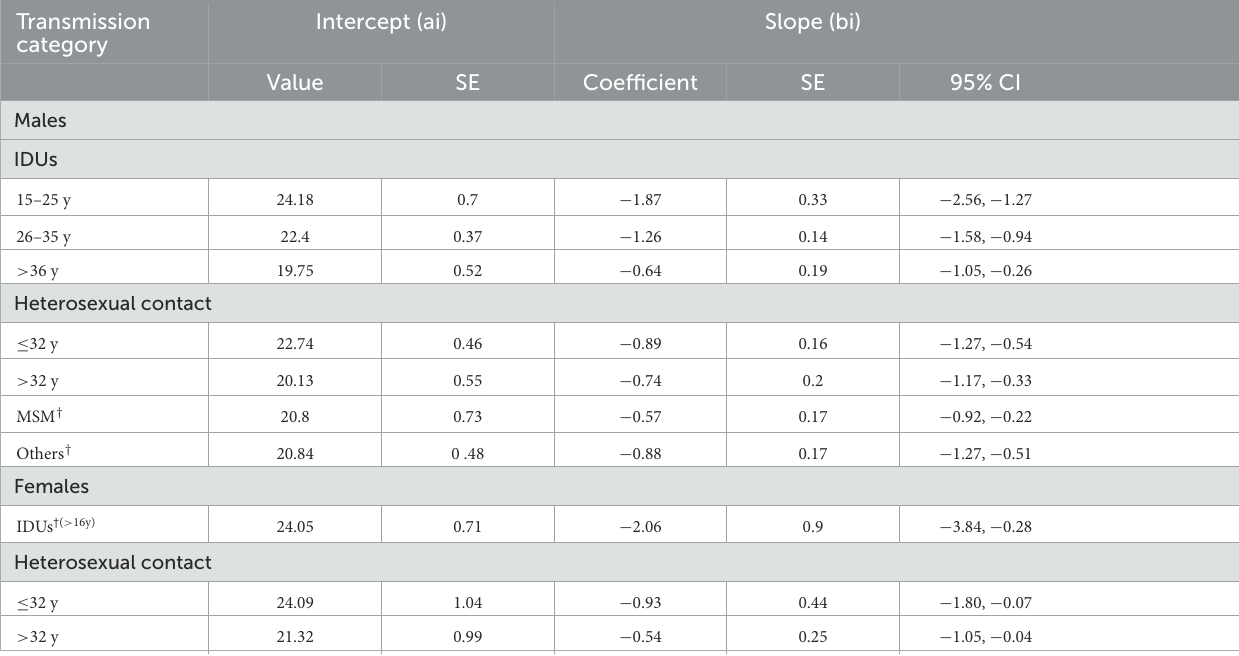
TABLE 2 Estimation of CD4 depletion model parameters using the national HIV/AIDS surveillance system database (HASS) in male and female patients. Transmission